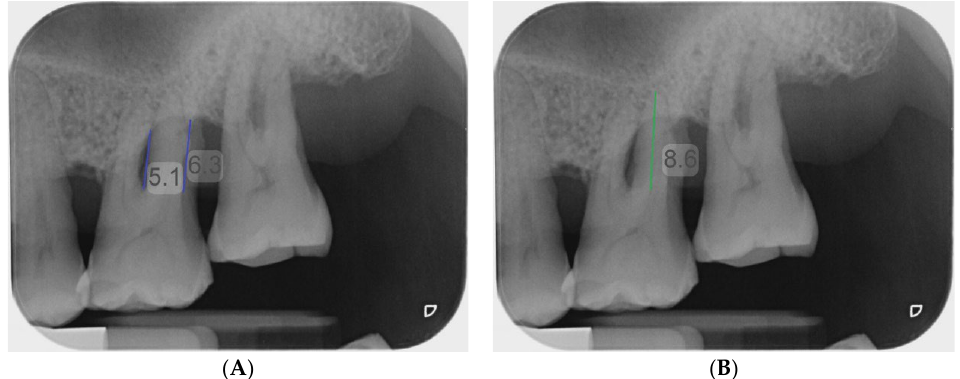
Figure 3. Measurement of vertical depth of furcation ( A ) and root length ( B ) on periapical radiograph using the measuring tool of Romexis (Planmeca).